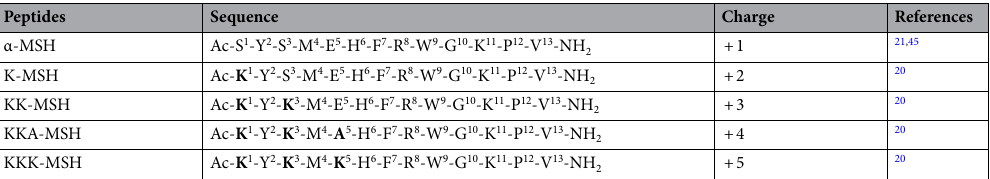
Table 1. Name, sequence and charge of α-MSH and its derivative analogues. The bold residues indicate the alterations in different analogues from the native